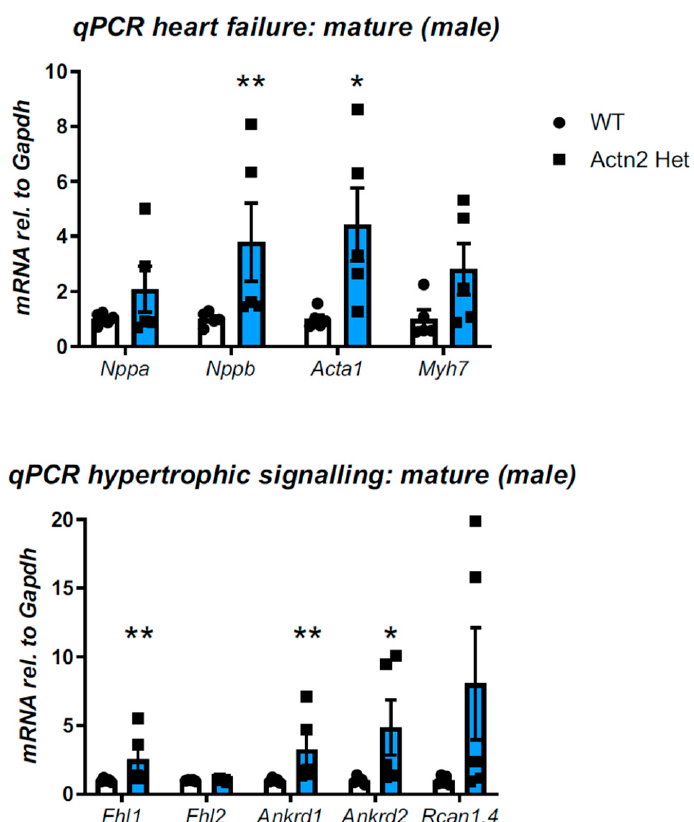
Figure 1. Targeted assessment of transcriptional changes by qPCR in mature male Het and WT hearts. Top: a panel of transcripts related to heart failure (fetal gene programme), Bottom: a panel related to hypertrophic signaling. All measurements are normalised to Gapdh . Significant changes are observed in the hearts of Het mice (Mann–Whitney U-test, n = 5 per group, age 266+/ − 1 d for both genotypes * p < 0.05, ** p < 0.01).